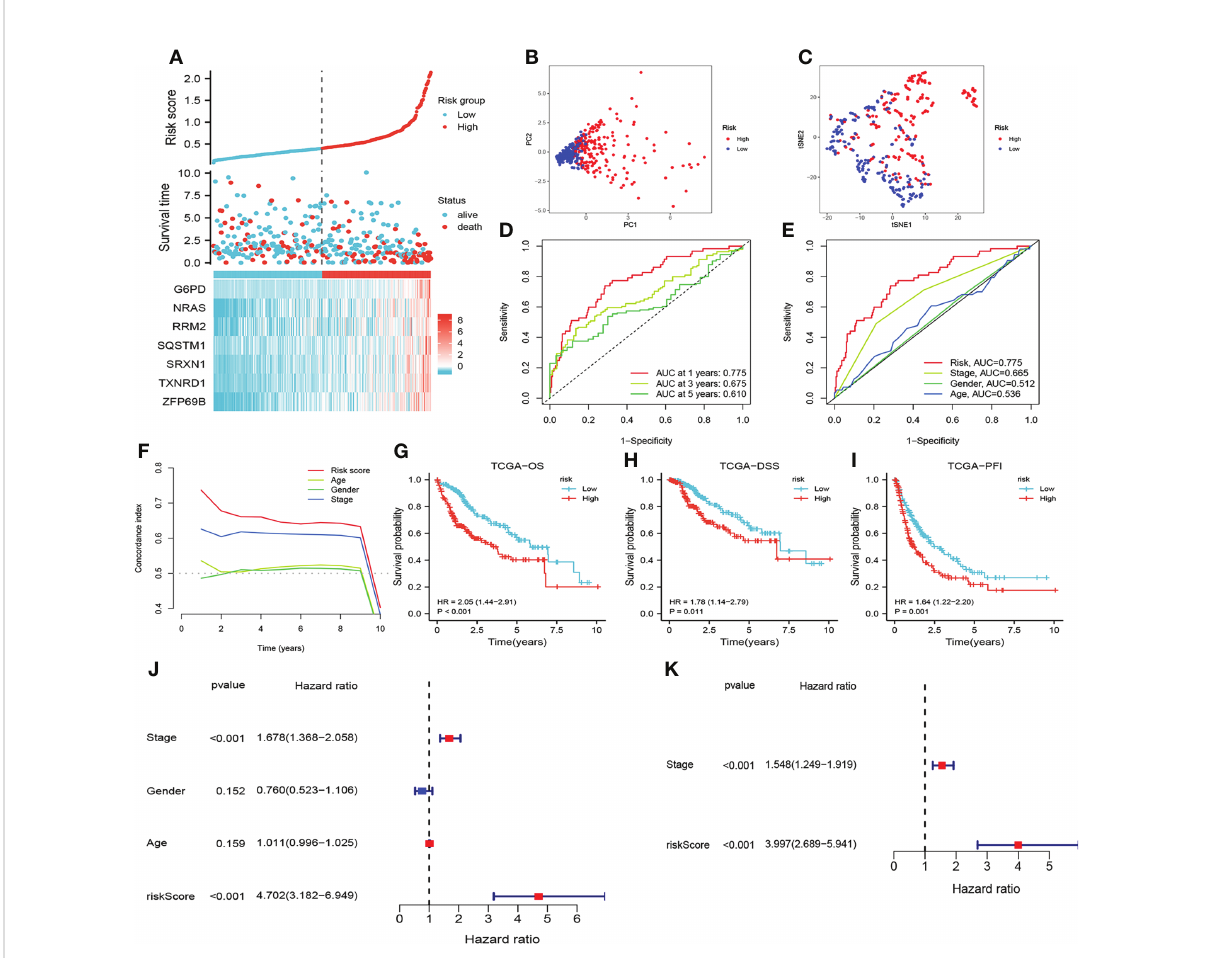
FIGURE 3 Assessment of the prognostic signature (CRFs) in TCGA. (A) survival status distribution. (B) Principal component analysis (PCA) plot. (C) t- Distributed stochastic neighbor embedding (t-NSE) plot. (D) timeROC curve of the risk score. (E) Receiver operating characteristic (ROC) curve of the age, gender, stage and riskScore. (F) C-index curve of the age, gender, stage and risk scores. (G) Kaplan – Meier (KM) curves of overall survival (OS). (H) KM curves of disease-speci fi c survival (DSS). (I) KM curves of progression-free interval. (J) Univariate Cox regression analysis of the age, gender, stage, and risk score in TCGA. (K) Multivariate Cox regression analysis of stage and risk scores in